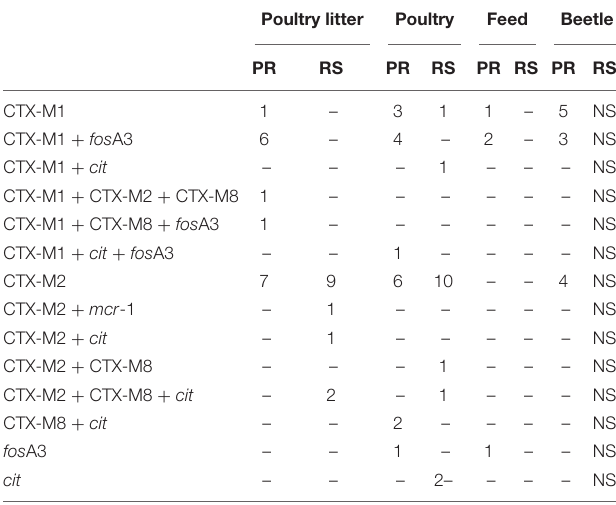
Inc Group Plasmid